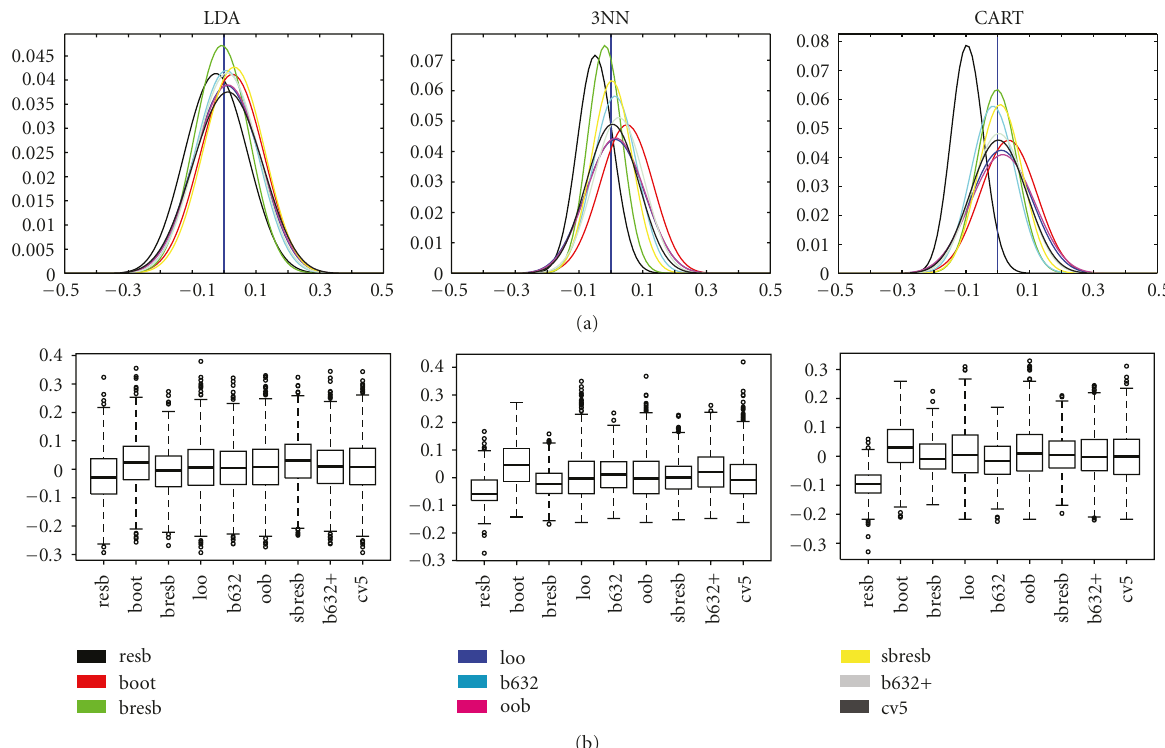
Figure 6: Empirical deviation distribution (a) and box plots (b), for lung cancer gene expression data, sample size n = 20, and dimensionality p = 2, with di ff erent base classification